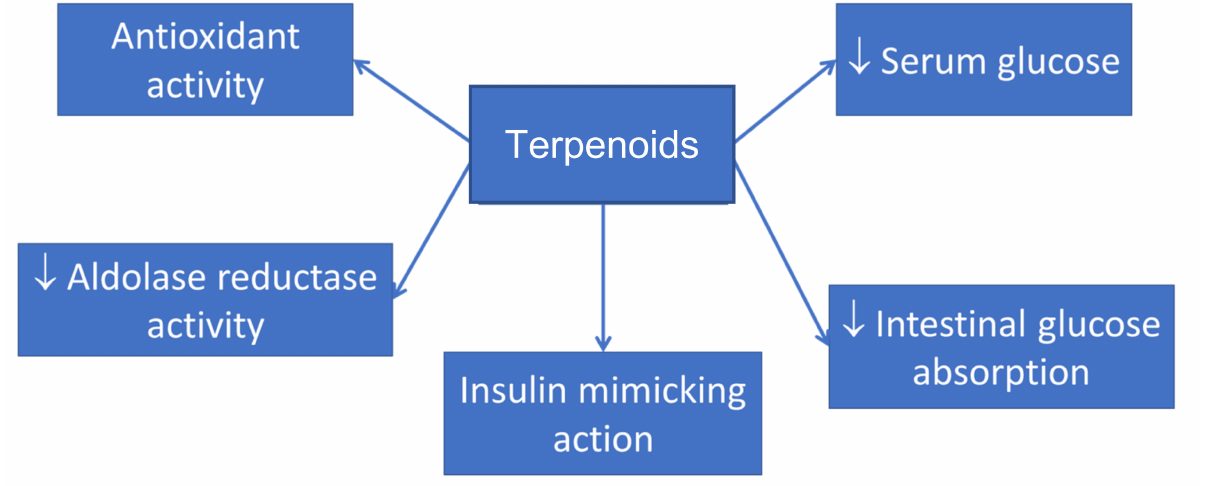
Figure 3. Beneficial effects of mushroom terpenoids (monoterpenes, diterpenes, sesquiterpenes, and